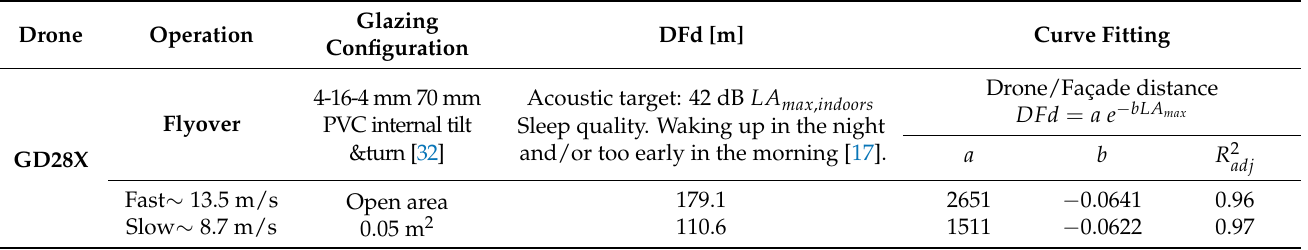
Table 2. Estimation of the optimal drone/façade distance DFd for drone GD28X at fast and slow flyover operation near a façade with a conventional window–open area 0.05 m 2